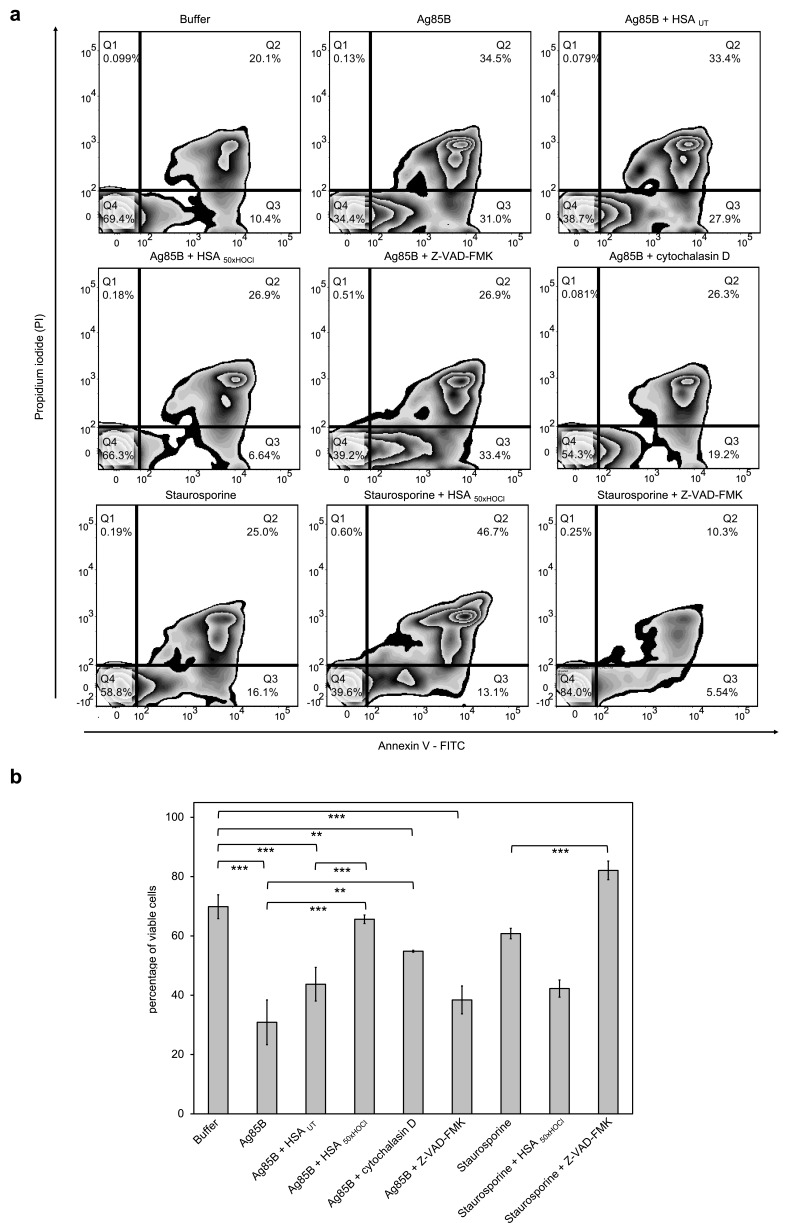
HOCl-treated serum albumin improves survival of neutrophil-like cells in the presence of the major mycobacterial protein antigen Ag85B.Differentiated neutrophil-like PLB-985 cells were preincubated with 50 μM Z-VAD-FMK, 155 μM native (HSA UT) or HOCl-treated HSA (HSA 50xHOCl) prior to the addition of 1 μM Ag85B or 2 μM staurosporine. After 1 hr (Ag85B) or 6 hr (staurosporine) of incubation, viability of the variously treated cells was assessed by flow cytometry using Annexin V/propidium iodide (PI) staining. Cells treated only with buffer served as control. (a) Annexin V-FITC vs. propidium iodide dot plots show all analyzed events. Staining of cells simultaneously with Annexin V- FITC (green fluorescence) and the non-vital dye PI (red fluorescence) allows the discrimination of viable, intact cells (FITC-, PI-; Q4), early apoptotic (FITC+, PI-; Q3) and late apoptotic/necrotic cells (FITC+, PI+; Q2). 20,000 events were acquired and recorded per sample. Data were analyzed using FlowJo (version 10) software. Results shown are representative of three experiments. (b) Results of three independent experiments for viable cells are shown (means and standard deviations). Student’s t-test: *p<0.05, **p<0.01, ***p<0.001.
10.7554/eLife.47395.050Figure 8—source data 1.Numerical flow cytometry data represented in Figure 8a and b.